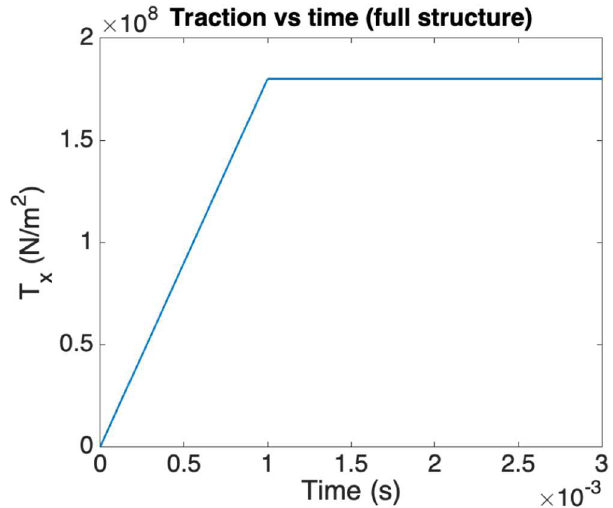
Fig. 8. Applied traction on the right boundary of the whole structure, along the x -direction.